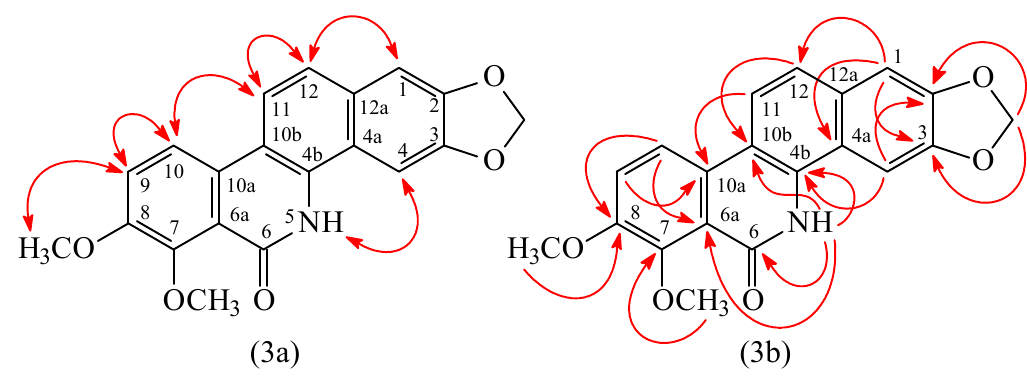
Figure 3. Key NOESY ( 3a ) and HMBC ( 3b ) correlations of 1